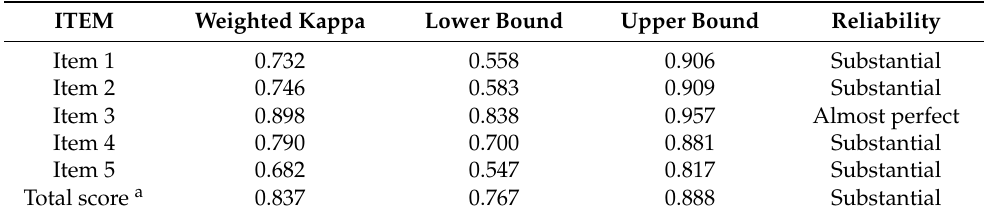
Table 4. Test–retest reliability of the items and the Short Form of the Fonseca Anamnestic Index total score.